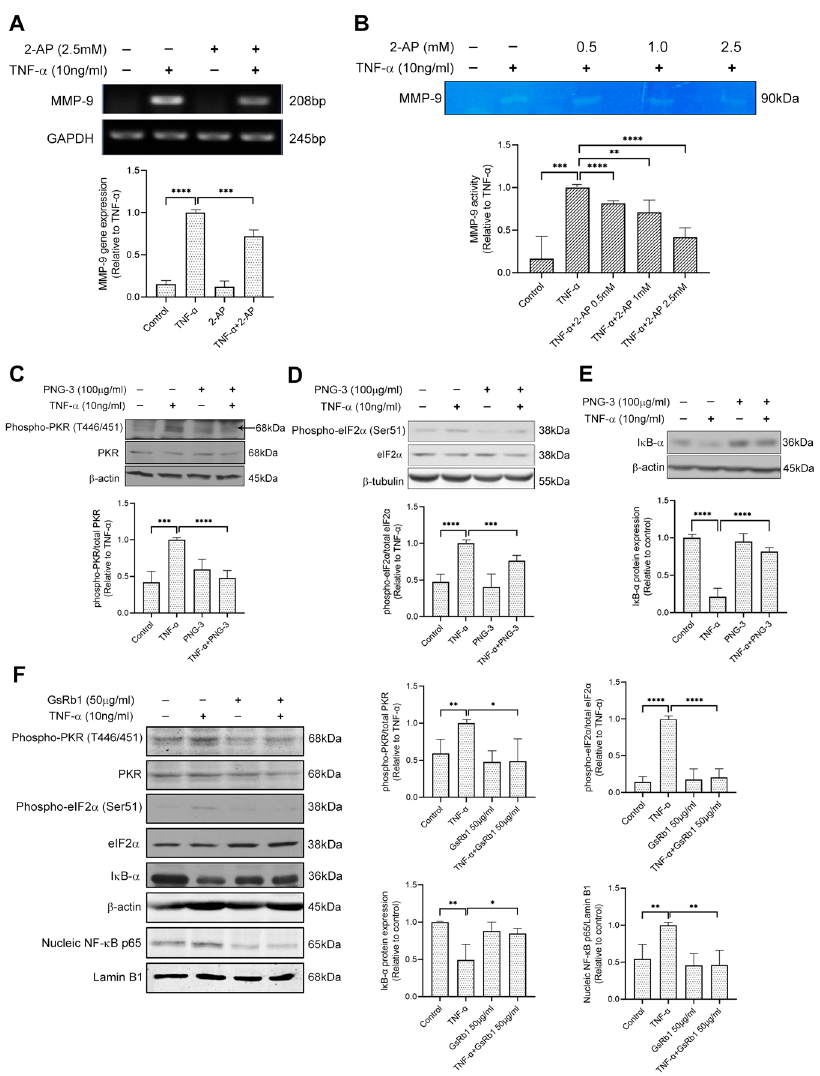
Figure 6. PNG-3 and Ginsenoside Rb1 (GsRb1) suppressed TNF- α -induced MMP-9 via PKR/NF- κ B in H9c2 cells. ( A ) 2-AP suppressed TNF- α -induced MMP-9 gene expression in H9c2 cell. ( B ) 2-AP suppressed TNF- α -induced MMP-9 activity dose-dependently in H9c2 cell. ( C – E ) PNG-3 suppressed the phosphorylation of PKR and eIF-2 α and preserved the expression of I κ B. ( F ) GsRb1 suppressed the phosphorylation of PKR, eIF-2 α and the nucleic expression of NF- κ B p65, as well as preserved the expression of I κ B. Results are shown as mean ± SD, N = 4 in each group. * p < 0.05, ** p < 0.01, *** p < 0.001, **** p < 0.0001 vs. control or TNF- α only.